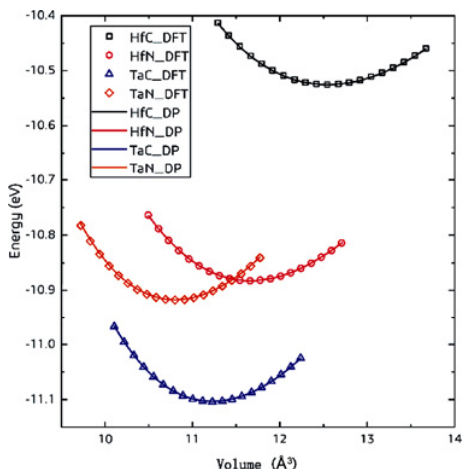
Fig 3 (a) Snapshot of solid–liquid coexistence configuration. Hf (big red atoms), Ta (big blue atoms), C (small black atoms), and N (small blue atoms) are distinguished by their sizes and colors. (b) Illustration of how interfaces between solid and liquid phases are detected by kernel density estimation and threshold value. The blue solid line is kernel density estimation of solid phase ratio along Z direction, while the vertical solid line is threshold value, and the horizontal dash lines indicate positions of